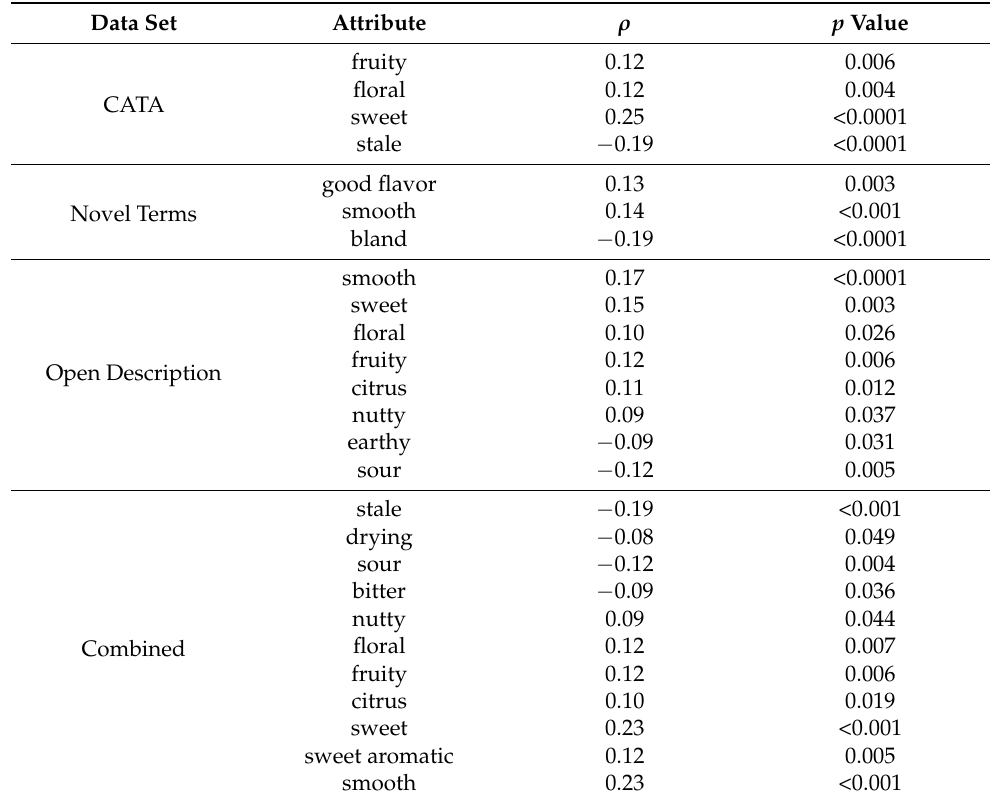
Table 4. Significant correlations between beer rank based on overall liking and individual attributes in each of the four sensory attribute data sets. Spearman rank correlation coefficients are provided ( ρ ) along with p values. Data